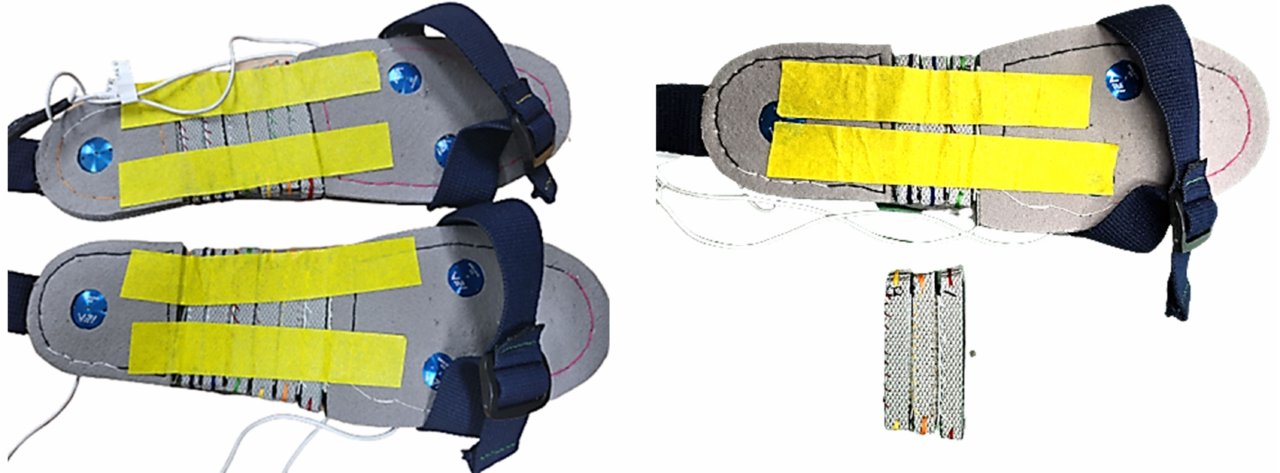
Figure 1. Developed shoes with three uniaxial load cells. By removing the middle blocks, the overall shoe size can be adjusted to precisely position the sensor on the subject’s heel and their 1st and 5th metatarsal. One block is approximately 10 mm